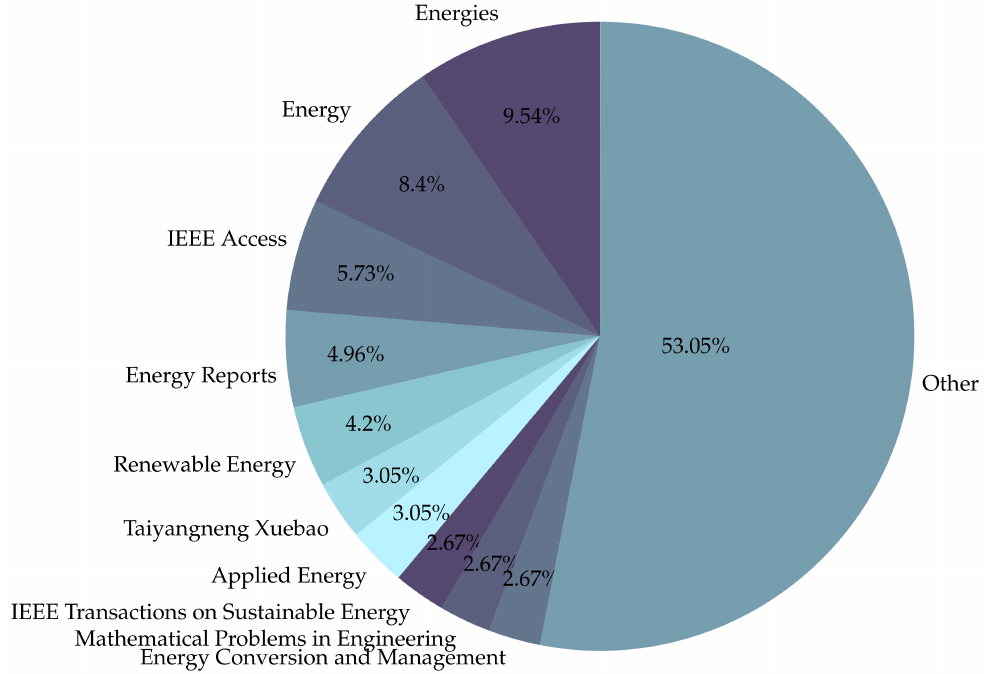
Figure 9. Top journals which contributed the most articles to the analyzed